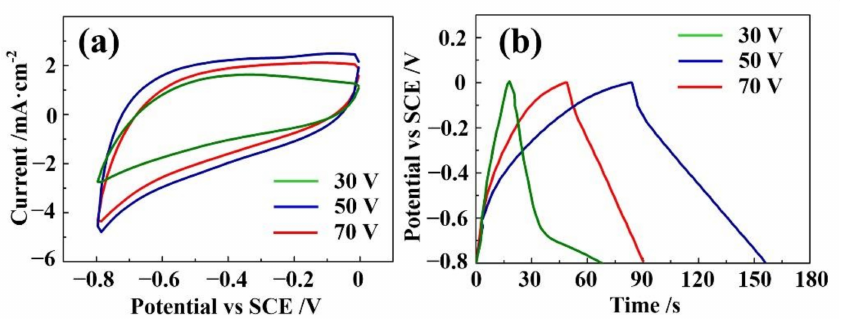
Figure 4. Capacitance performances of NASS samples with different anodic oxidation potential. ( a ) CV curves at scan rate of 100 mV · s − 1 . ( b ) GCD curves at current density 1 mA · cm − 2